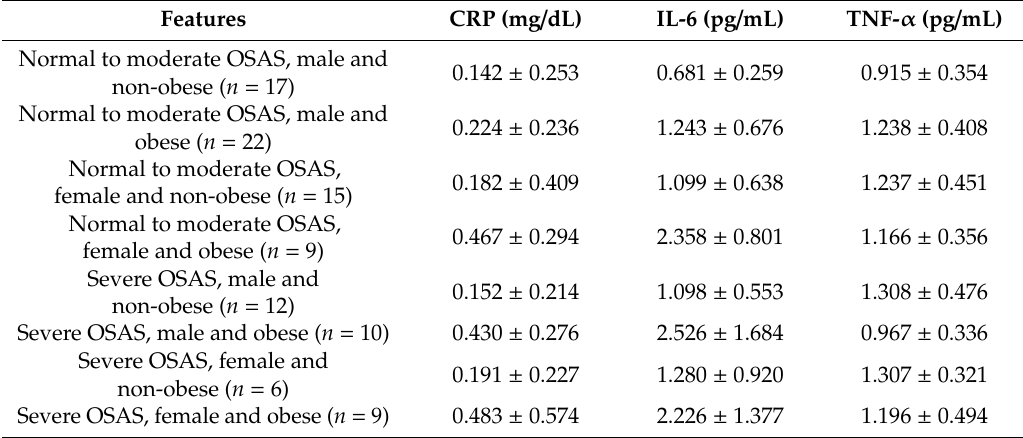
Table 4. The levels of circulatory inflammatory biomarkers in various combinations of the three studied